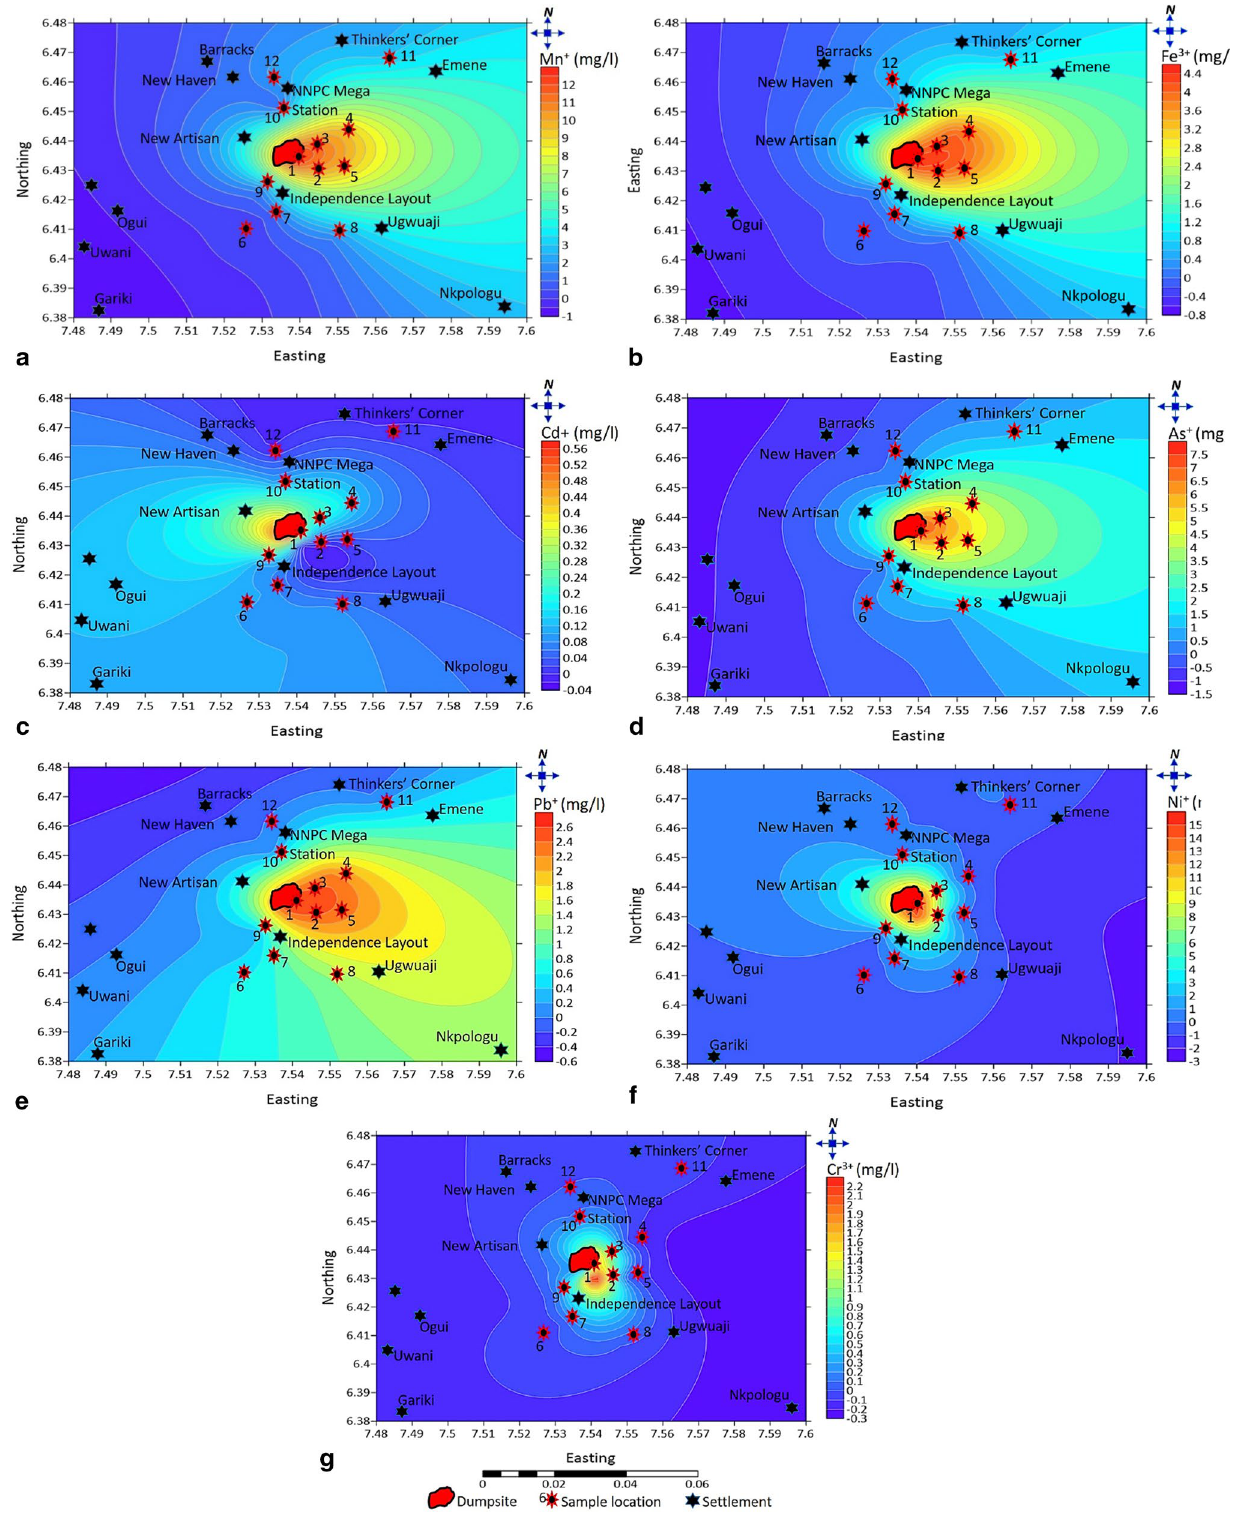
Fig. 10 Contour plots of heavy metal concentrations, a . Mn + , b . Fe 3+ , c . Cd + , d . As + , e . Pb + , f . Ni + , and g . Cr